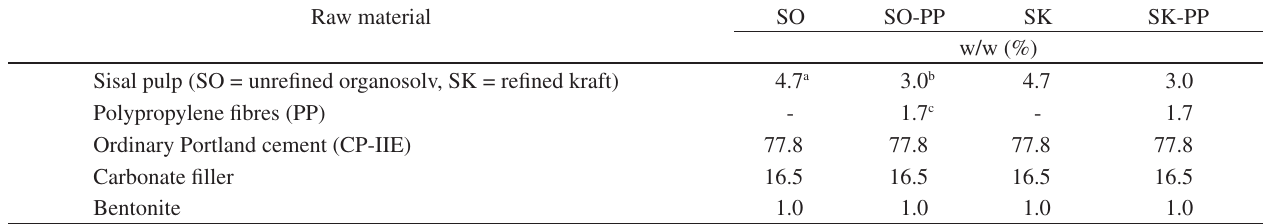
Table 3. Mix-design of the fibre-cement composites.